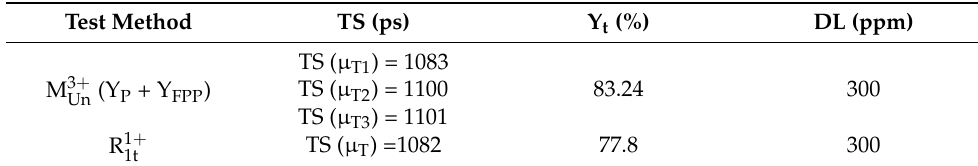
Table 2. Test results for different test specifications and methods.